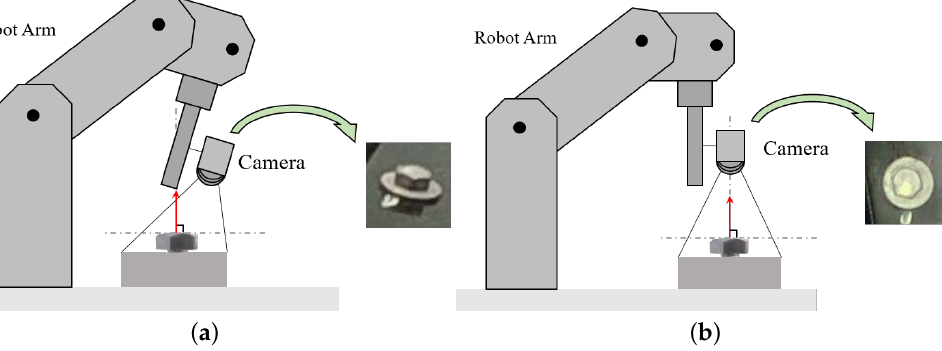
Figure 3. Pictures of screw taken by the robot arm from different angles. The red arrow represents the normal vector on the upper surface of the